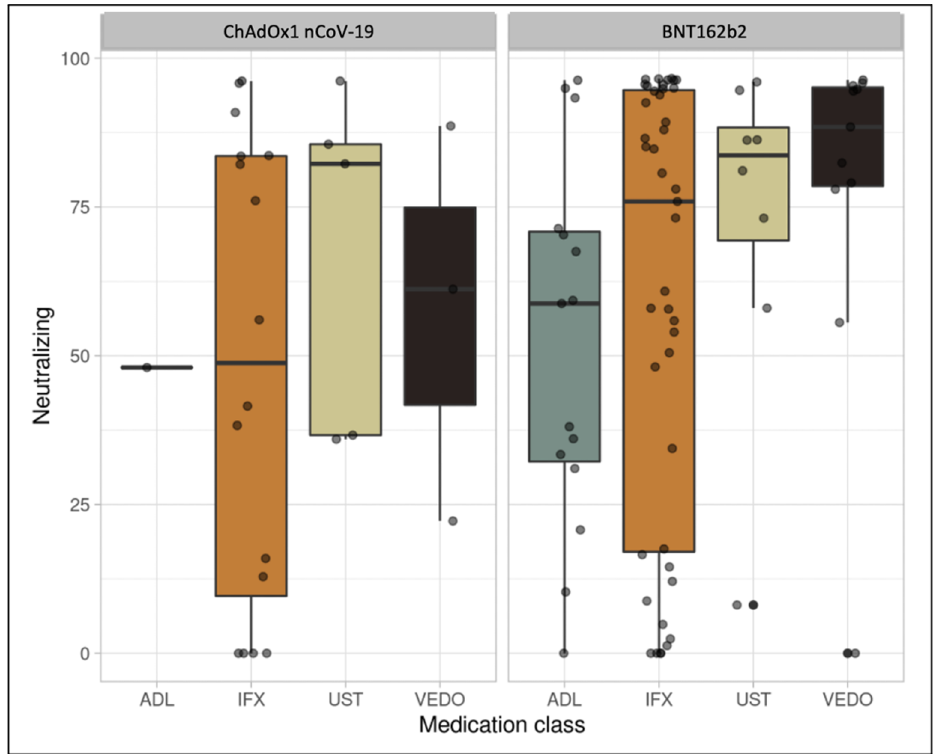
Table 3. Serological response in participants vaccinated with ChAdOx1 nCoV-19 and receiving bi- ologic therapies.